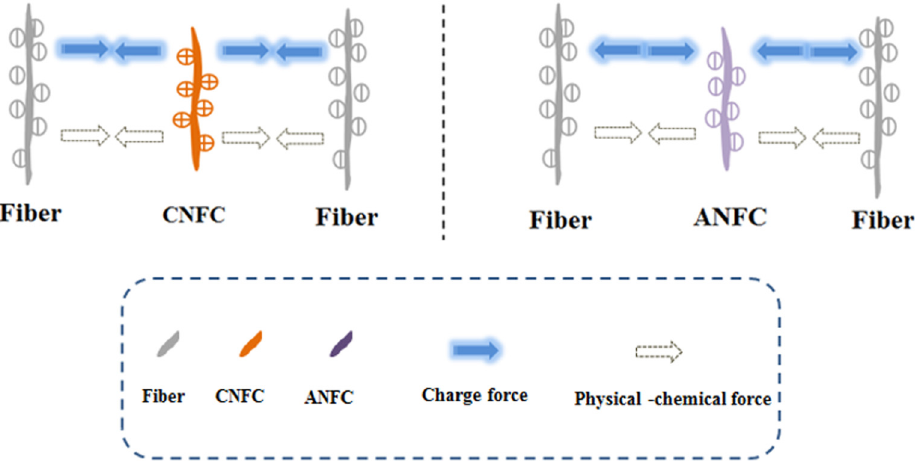
Figure 9: Reinforcement mechanism of CNFC/ANFC and cork fi ber insulation